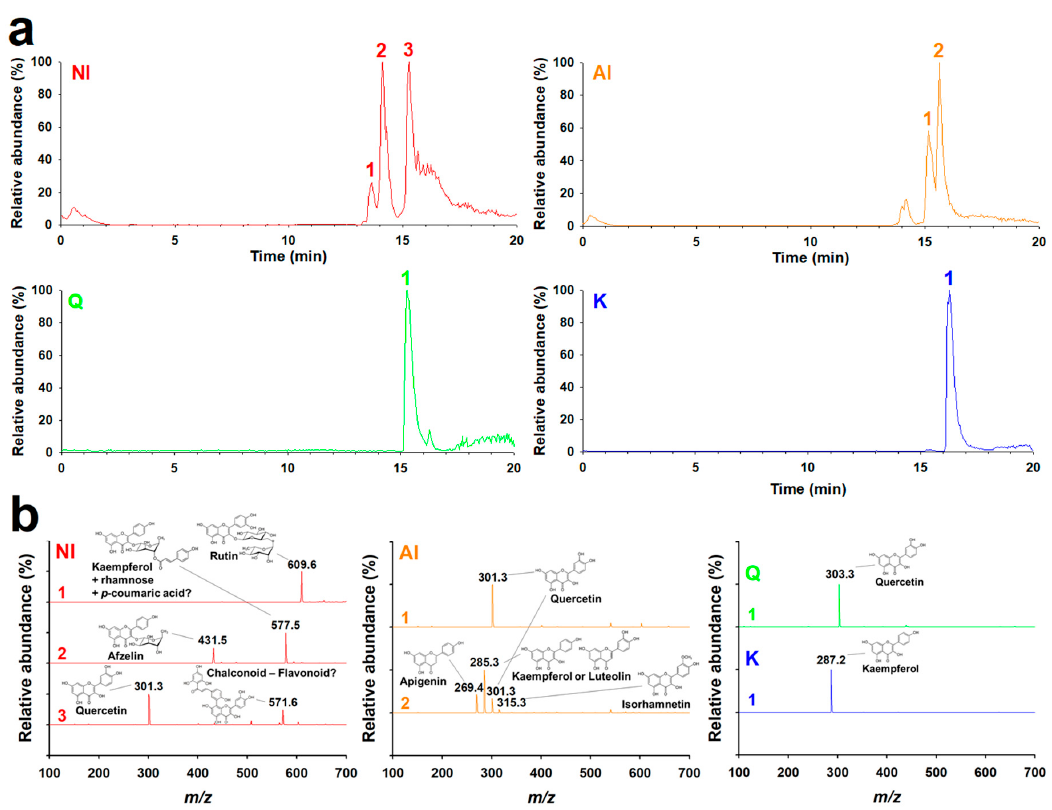
Figure 1. MS/MS analysis of the non-hydrolyzed isolate (NI) and acidolyzed isolate (AI) of Ginkgo biloba leaf. ( a ) Chromatograms and ( b ) mass spectra of NI ([M] − ) and AI ([M] − ), quercetin (Q; [M] + ), and kaempferol (K; [M] + ), following electrospray ionization in the HPLC-MS/MS measurements.